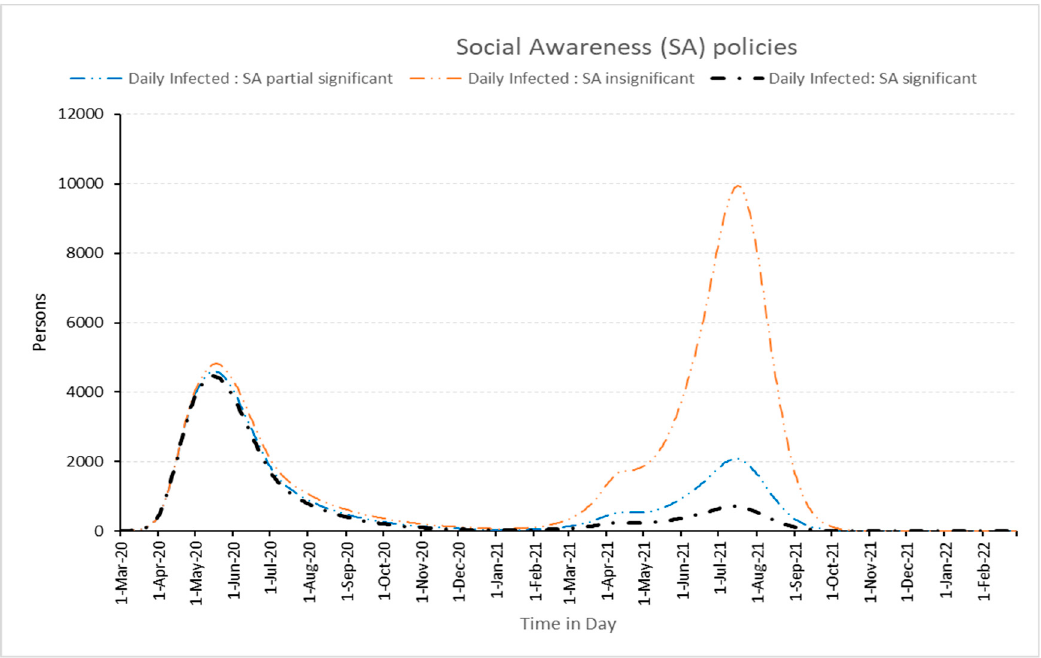
Healthcare 2023 , 11 , 260 Figure 9. Impact of different social awareness efforts policies on daily infected people.